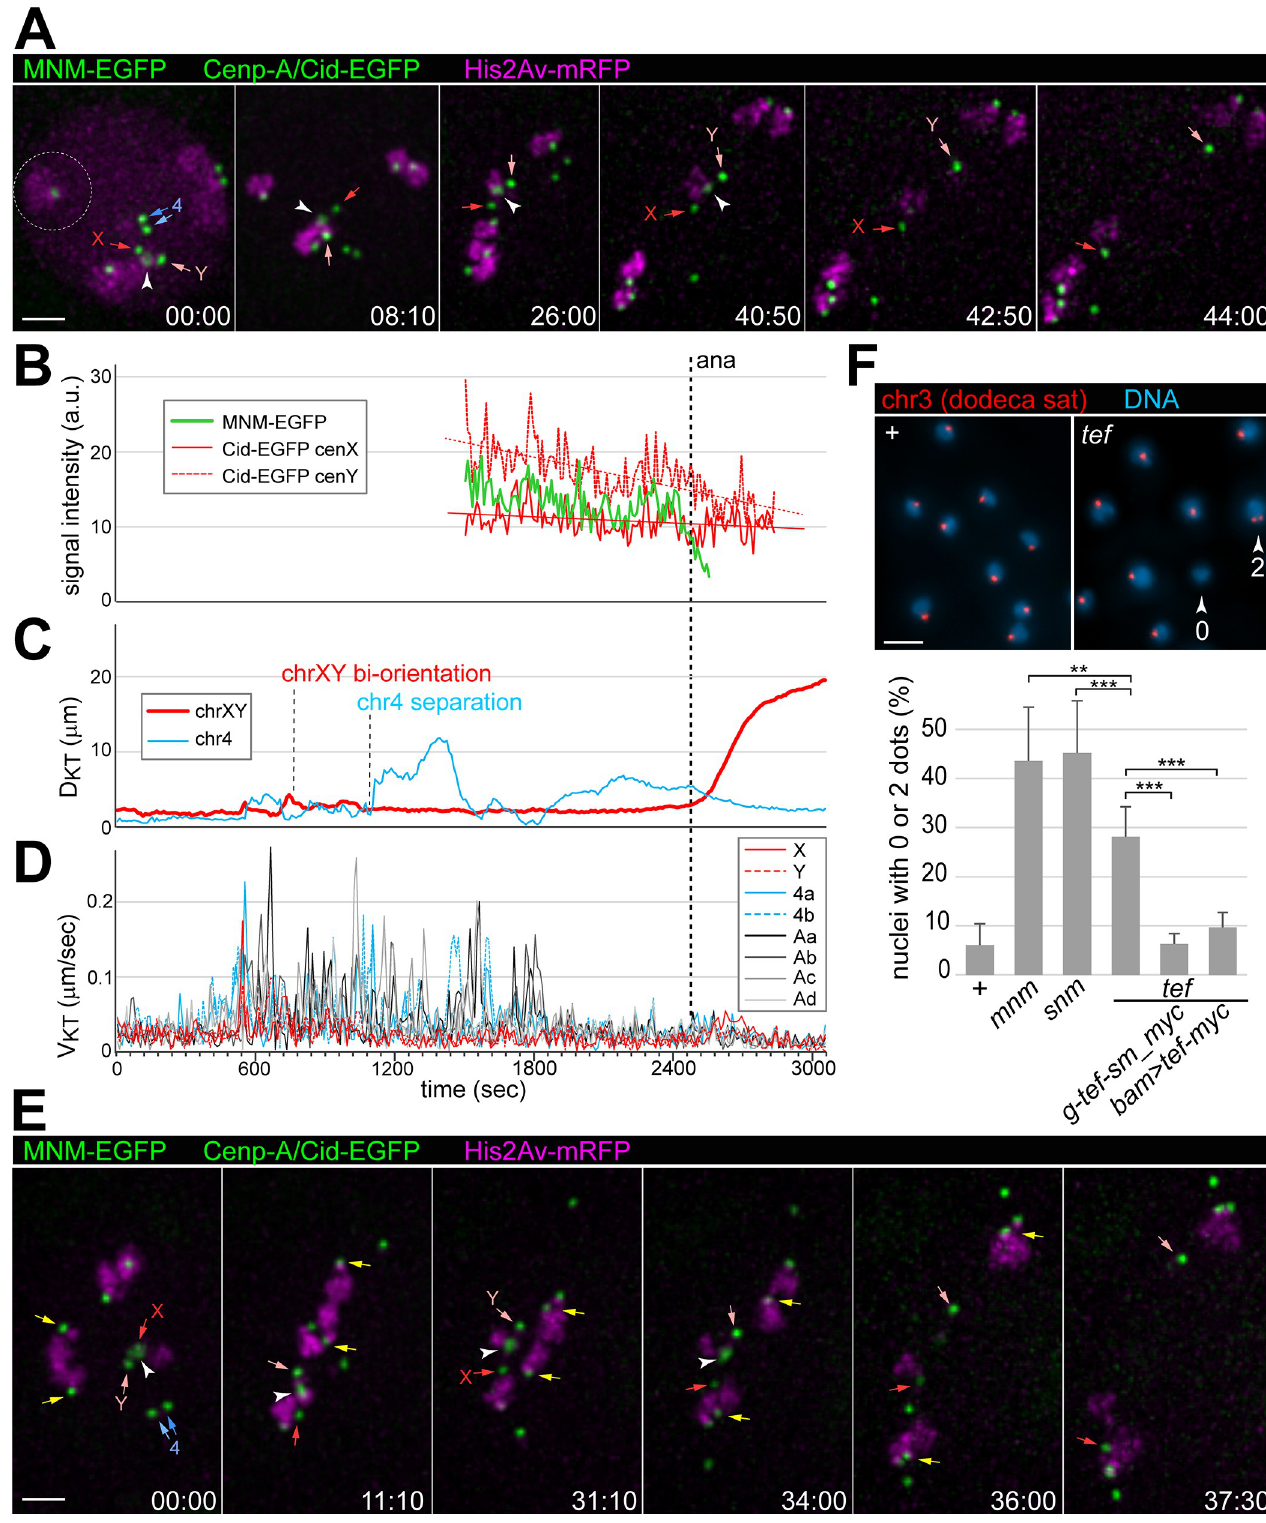
Fig 1. Autosome segregation in M I is less defective in tef compared to mnm and snm mutants. (A-E) Time-lapse imaging of progression through M I in tef mutants expressing His2Av-mRFP, Cenp-A/Cid-EGFP and MNM-EGFP. Autosome conjunction defects of varying severity are illustrated with a